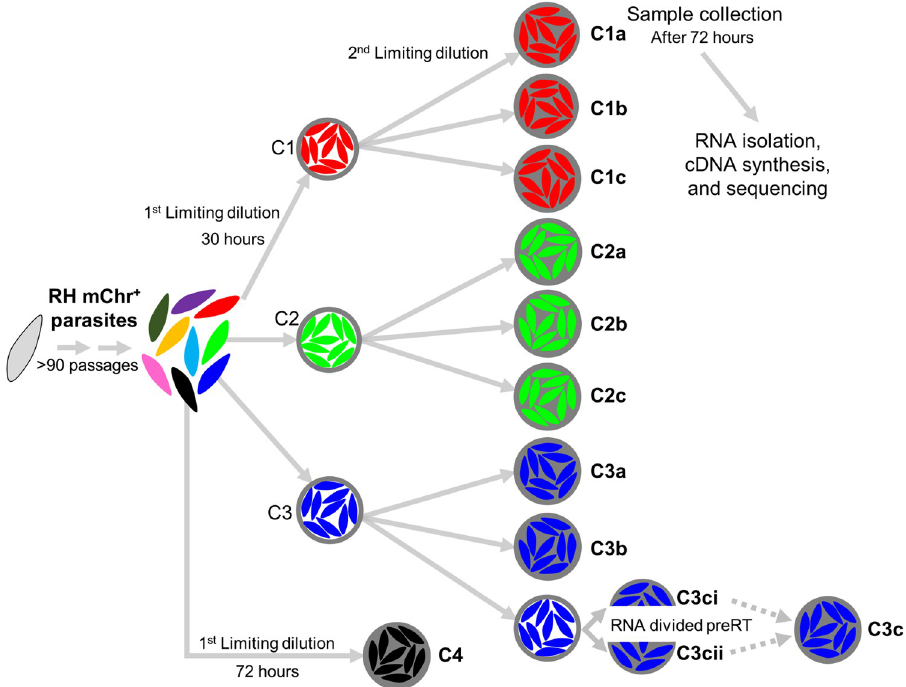
Fig 1. Toxoplasma subcloning schematic. A population of mCherry + (mChr + ) RH parasites was passed at least 90 times in human foreskin fibroblasts (HFFs) after thawing. Independent clones (indicated by colors and given